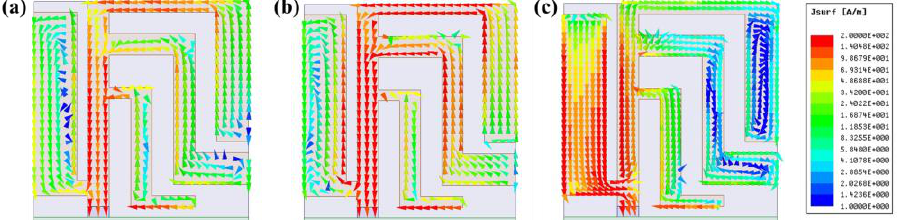
Figure 9. Surface current distribution of the planar USB dongle antenna at ( a ) 2.45 GHz, ( b ) 3.51 GHz, and ( c ) 5.45 GHz.